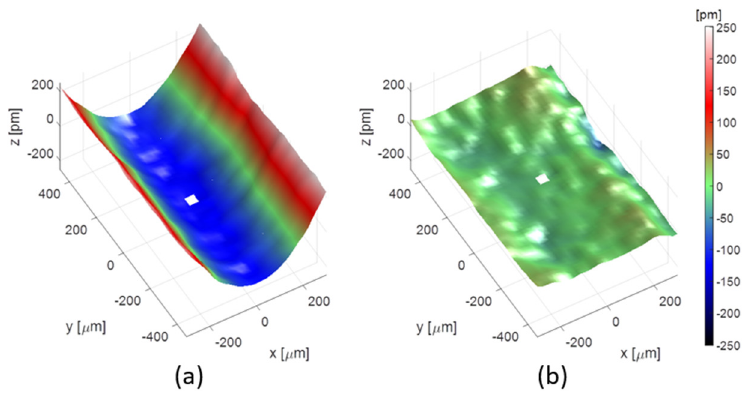
Figure 6. Wavefront map before ( a ) and after ( b ) the correction applied to the mirror.